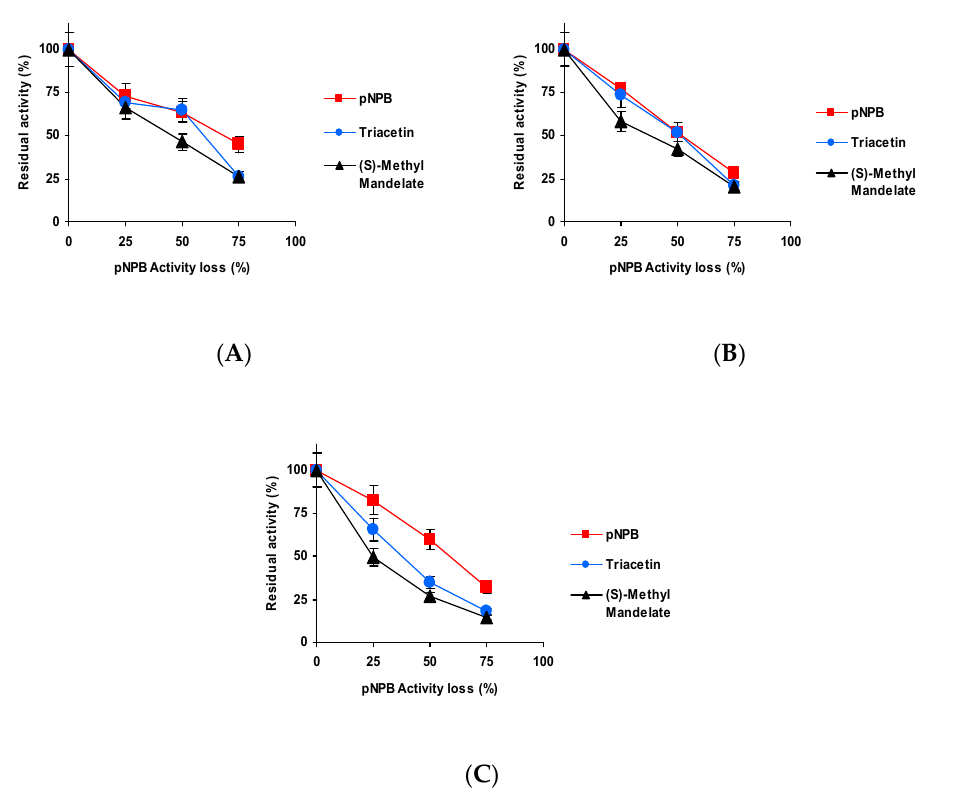
Figure 6. Effect of the inactivation pH on the residual activity versus different substrates of CALB biocatalysts activity blocked with hexylamine. Inactivation was performed at ( A ) pH 5.0 and 80 °C, ( B ) pH 7.0 and 75 °C and ( C ) pH 9.0 and 60 °C. The substrates used were: p NPB; triacetin; and ( S )-methyl mandelate. Other specifications may be found in Methods section.